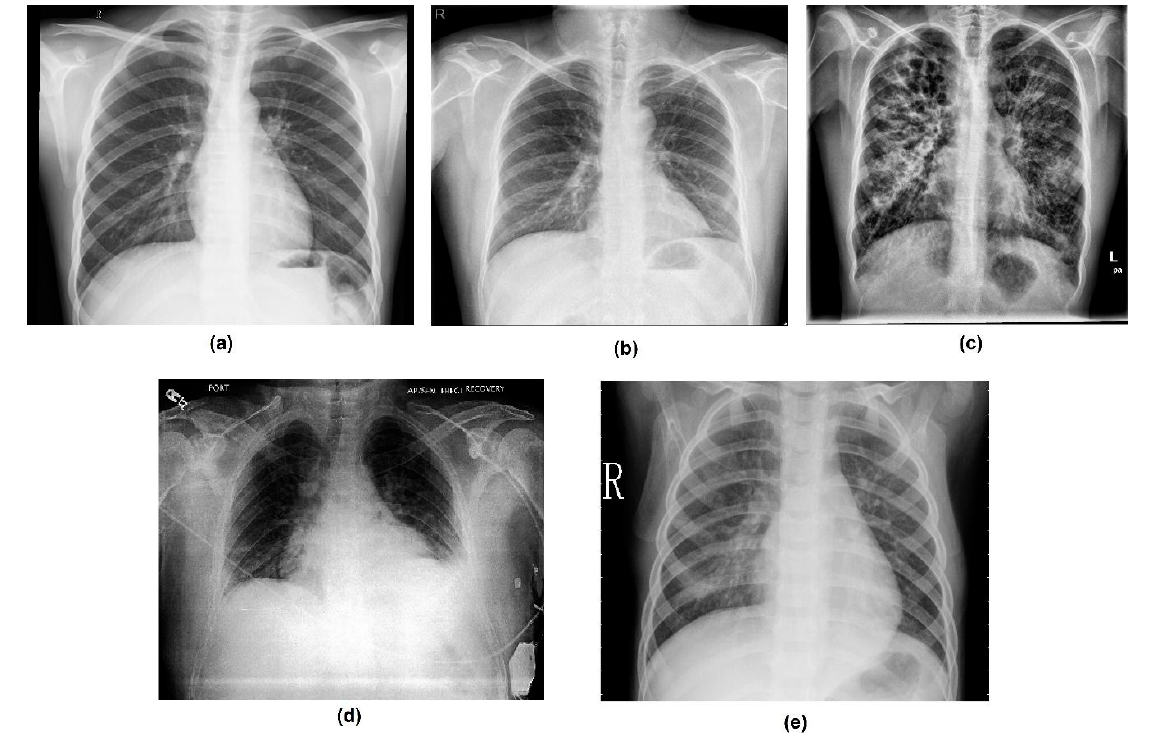
Figure 1. Sample x-ray images of ( a ) normal, ( b ) Bacterial Pneumonia, ( c ) COVID-19, ( d ) Lung Opacity and ( e ) Viral Pneumonia.